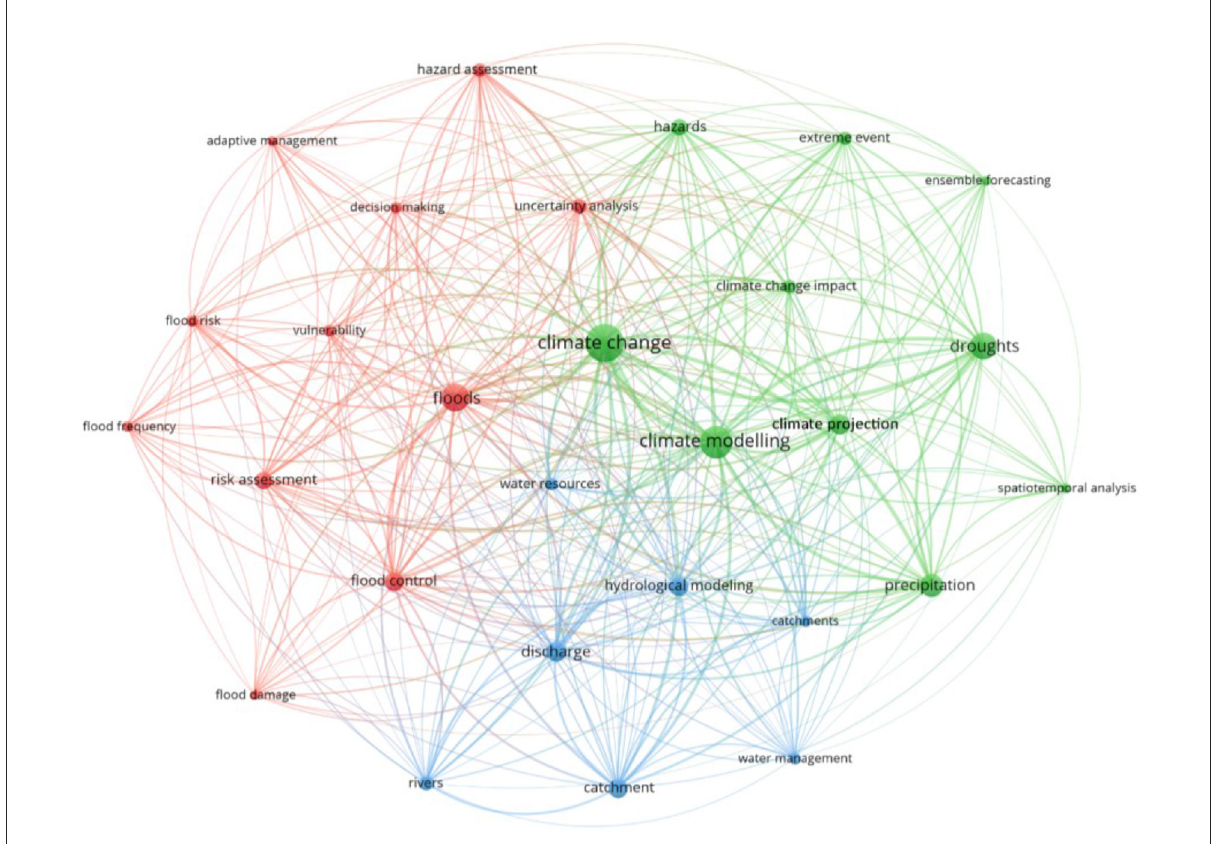
FIGURE3 Systematic frequency analysis using Vosviewer tool